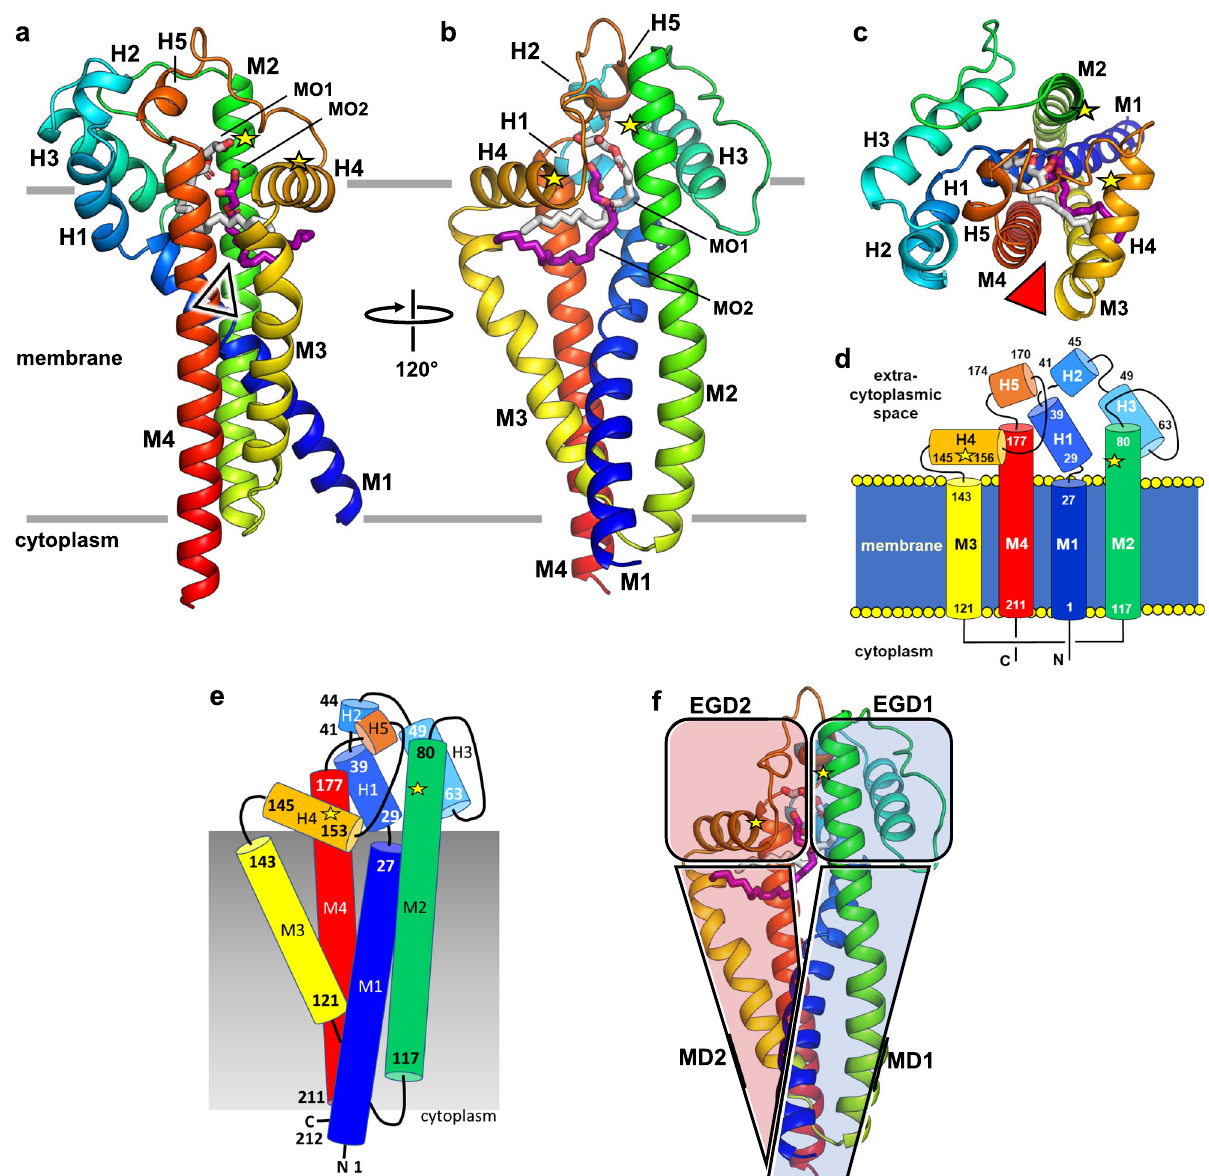
Fig. 2 Overall architecture of apo-Lit from B. cereus . a View from the membrane plane into the active site from the front. Substrate and product putatively enter and leave the active site via a fenestration (arrowhead) that opens between the extracyctoplasmic halves of M3 and M4. Structured lipids in the active site pocket have grey and purple carbon atoms for clarity. Approximate location of catalytic residues, His85 and His153, are marked with yellow stars on M2 and H4, respectively. Monoolein molecules that coat the surface of the protein have been omitted for clarity. Approximate location of the membrane boundaries are shown as horizontal lines. b View from the membrane plane into the active site from the back. c View from the extracellular space into the active site. Fenestration marked with an arrowhead. d Topology of Lit in a simpli fi ed representation to highlight the elements of symmetry in the protein. e A view of the protein from the back with helices shown as rods. f The pseudo twofold structural symmetry in Lit, illustrated by dividing the protein into N- and C-terminal halves (transparent blue and red), can be seen by comparing e and f which are in the same orientation. MD and EGD correspond to the membrane domain and the extracellular globular domain, layer chromatography (TLC) provided the molecular weights involved were not too great. To facilitate visualisation, the lipo- protein substrate was labelled with a fl uorophore (FP2) (Sup- plementary Fig. 8). FP2 has a DAG-modi fi ed cysteine at the N-terminus followed by two serines and a C-terminal lysine with the fl uorophore, 2-aminobenzoyl (Abz), in amide linkage to its ɛ -amino group. By optimising TLC mobile phases, one was identi fi ed that cleanly separated the Lit substrate and product.